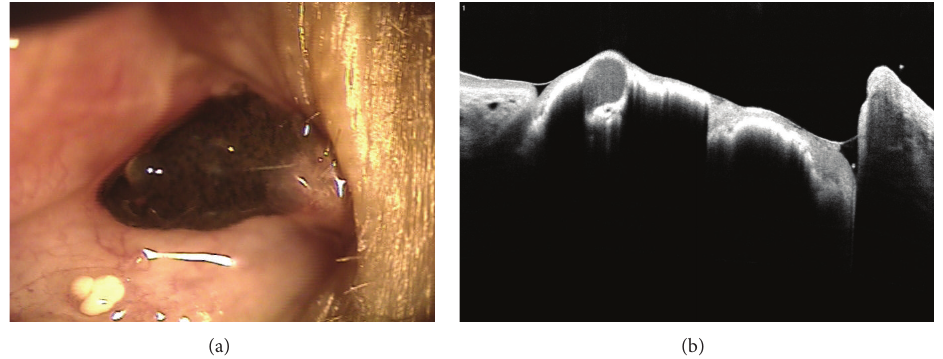
Figure 10: Anterior segment photography (a) and OCT image (b) of conjunctival tumor (nevus).